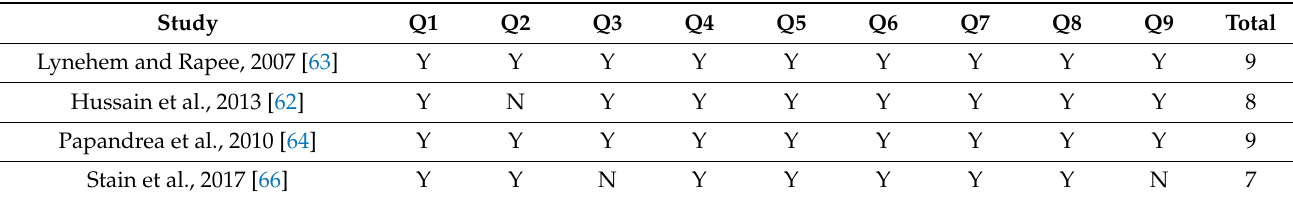
Table 1. Quality assessment results of the 10 studies included in the